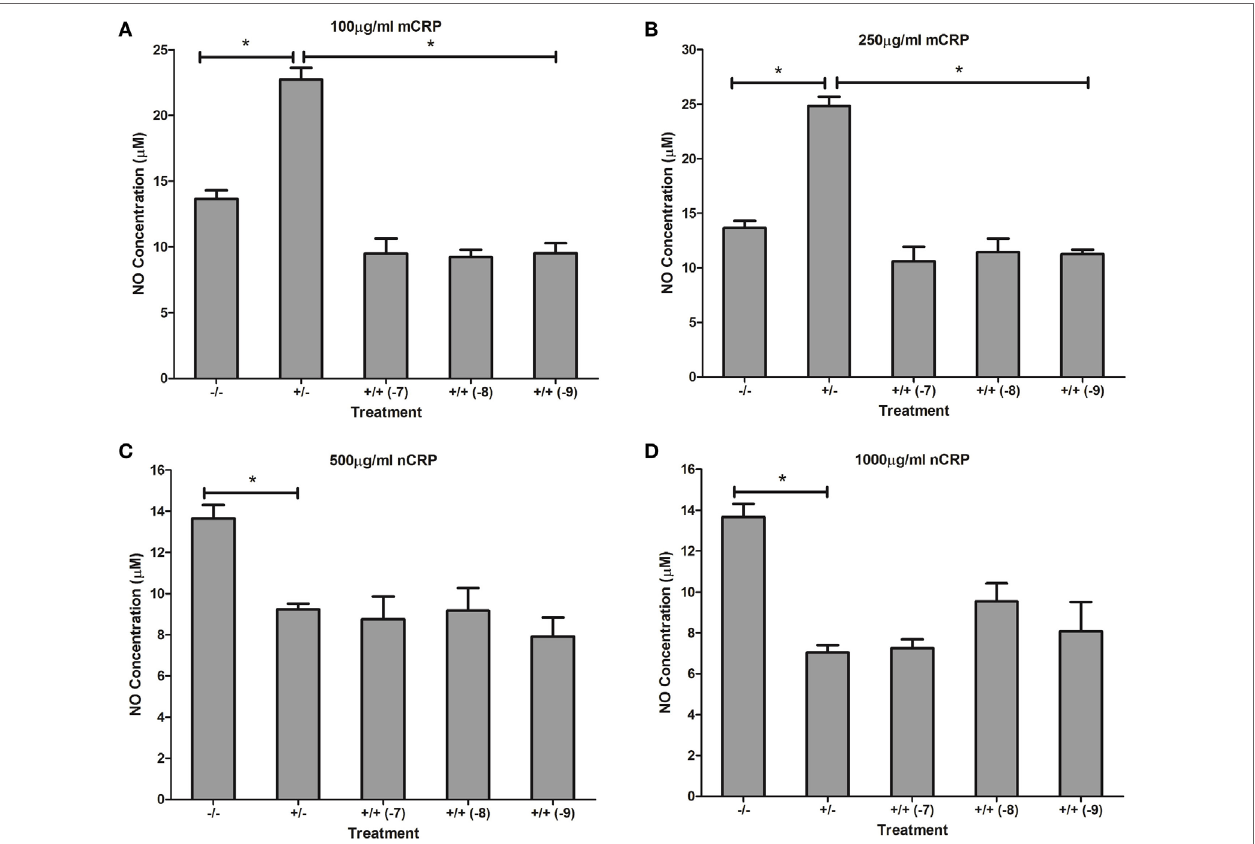
FigUre 8 | Effect of estrogen on C-reactive protein (CRP)-mediated nitric oxide (NO) production by lipopolysaccharide (LPS)-activated U937 monocytes. Estrogen reversed monomeric CRP (mCRP)-induced NO production (a,B) but had no effect on native CRP (Ncrp)-mediated inhibition of NO production (c,D) by activated U937 monocytes. − / − represents the untreated negative control with no CRP or estrogen supplementation. + / − represents treatment with CRP alone. + / + represents treatment with both CRP and estrogen. The number in parentheses indicates the concentration (1 × 10 − 7 , 1 × 10 − 8 , or 1 × 10 − 9 M) of estrogen. *Denotes a significant ( P < 0.05; n = 12) difference in NO production following treatment with CRP or co-supplementation with estrogen. Errors bars represent the